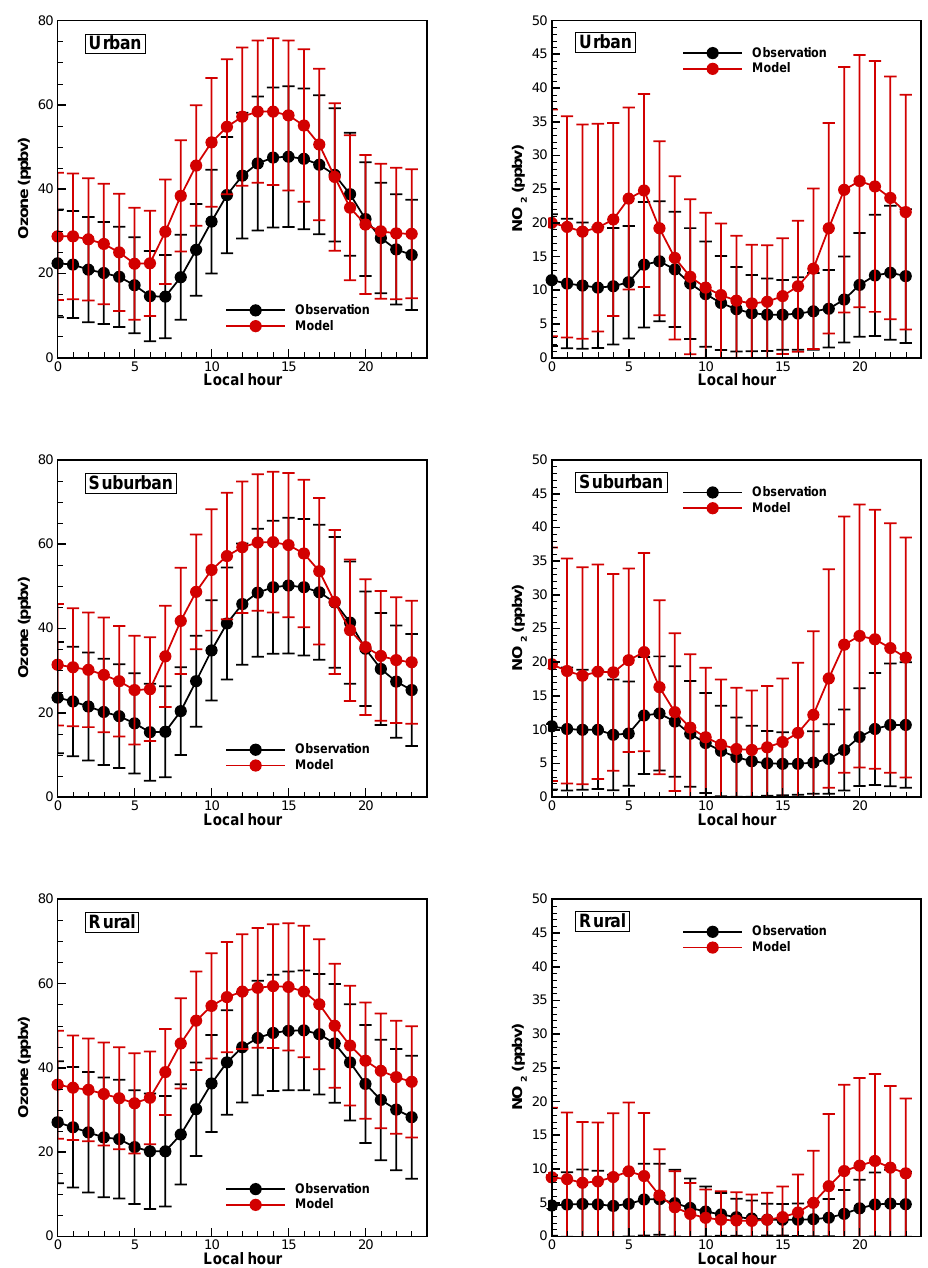
Fig. 10. Diurnal profiles of ozone and NO 2 at urban, suburban, and rural sites in August 2010. Average concentrations of the AQS observa- tions and their NAQFC counterparts are shown with their standard deviations as a function of local